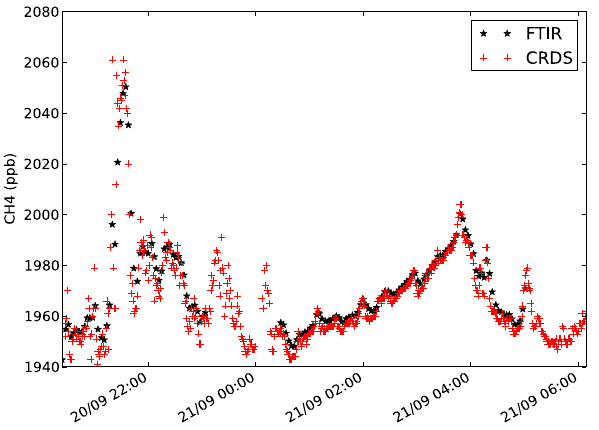
Figure 7. Measurements in the aeration area of the basin. Upper panel: methane concentration vs. time. Lower panel: respective vol- ume of injected air during the same time